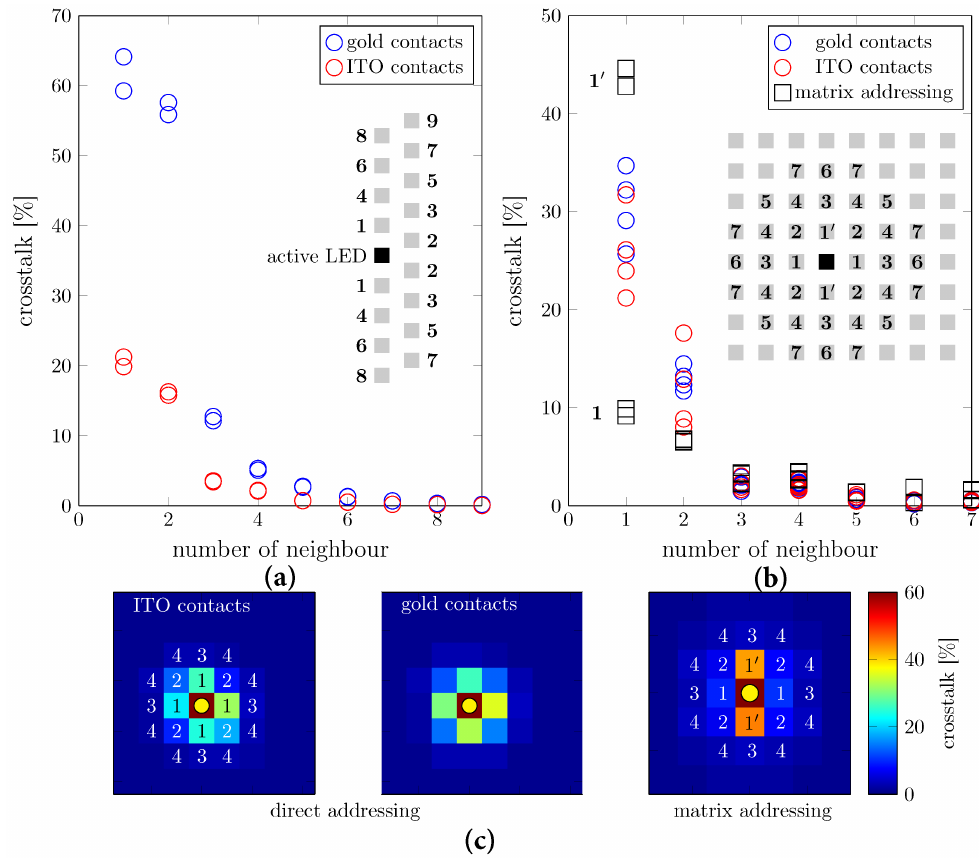
Figure 6. The comparison of the optical crosstalk between the pixels for gold and ITO contacts for the double-line ( a ) and array ( b ). For the latter, we also compared with the matrix addressing LED array of the same pixel size and period. The crosstalk was calculated at a plane 100 nm above the top surface of the LEDs for the direct addressing and at the Si 3 N 4 /air interface for the matrix addressing arrays. We used Equation (1). The insets show the scheme of the LED alignment and the position of the different neighbors with respect to the active LED (indicated with the bold square). On the bottom line ( c ), we show the maps of crosstalk for the directly and matrix-addressed LED arrays to emphasize the anisotropic crosstalk in the latter case. Every square corresponds to an LED pixel, and the active pixel is marked with a yellow dot. The two panels on the left show the results for the direct addressing 8 8 arrays with ITO and gold contacts, exhibiting a substantially isotropic behavior. × For the matrix addressing scheme (rightmost panel), crosstalk is larger in direction of the TCO top contact lines along y , but it is largely suppressed along x due to the etched